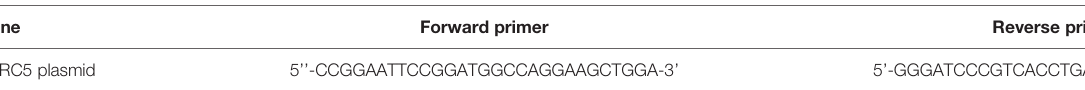
TABLE 2 | NLRC5 plasmid